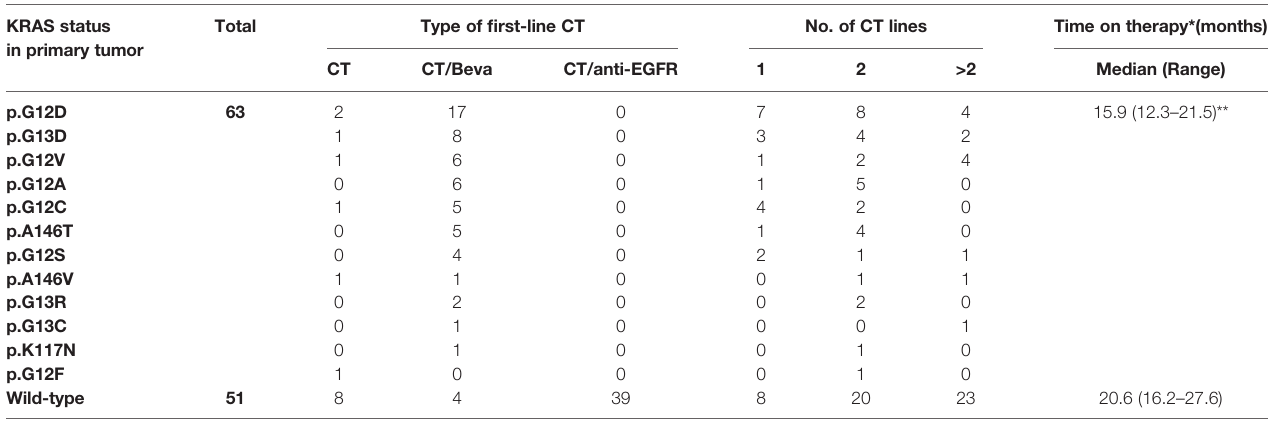
TABLE 2 | Treatment characteristics according to KRAS status at